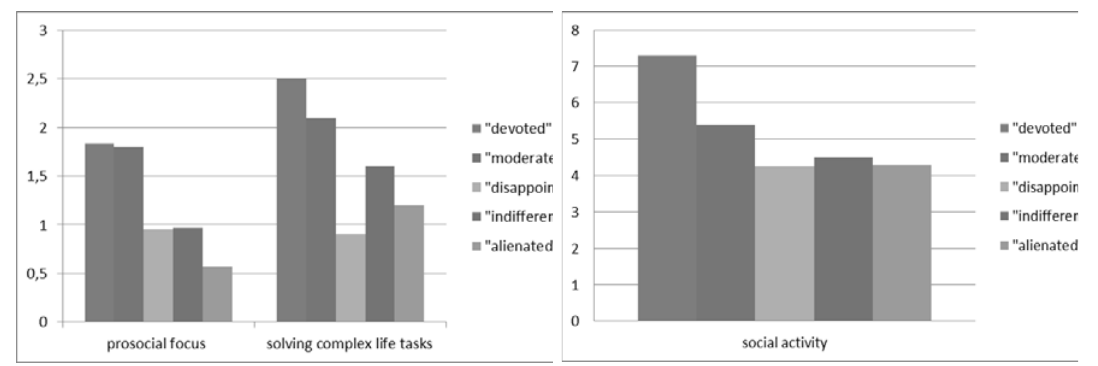
Prosocial focus of activity of citizens with various types of civic identity Source: Own research